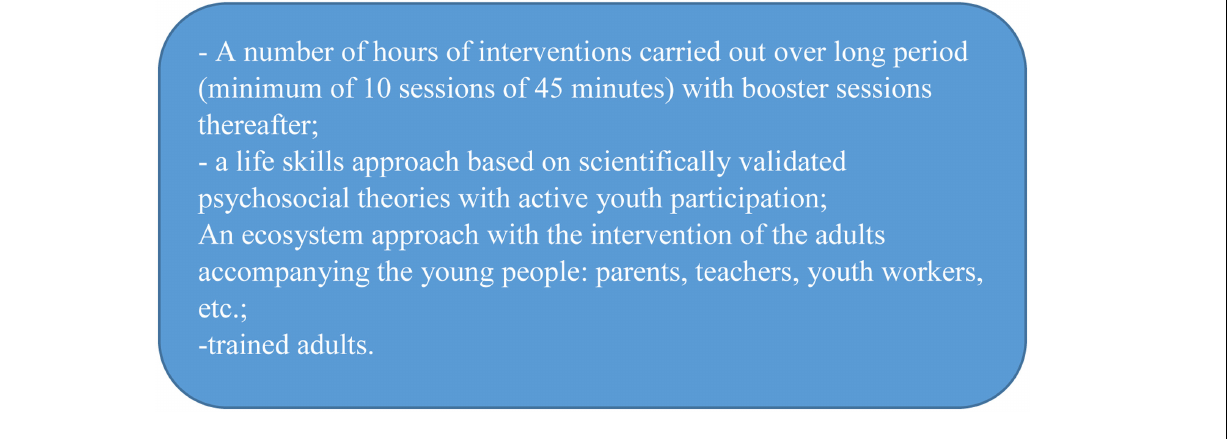
FIGURE 3 | Keys elements of an effective